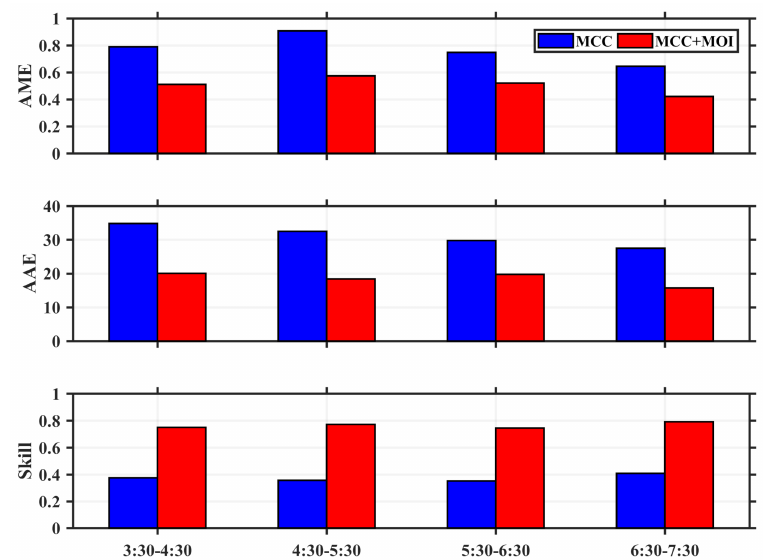
Figure 6. Comparison of AME, AAE, and skill for velocities from the OSU model and from GOCI imagery using MCC and MCC+MOI for four different time intervals on 13 May